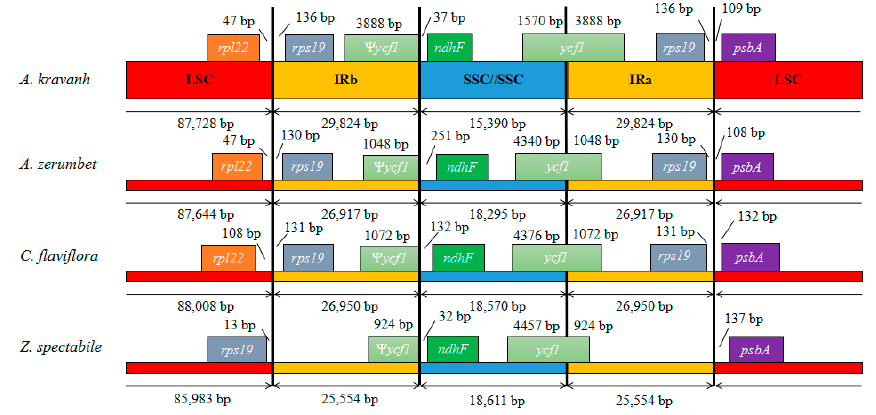
Figure 4. Comparison of the borders of LSC, SSC and IR regions among four chloroplast genomes. Ψ , pseudogenes.